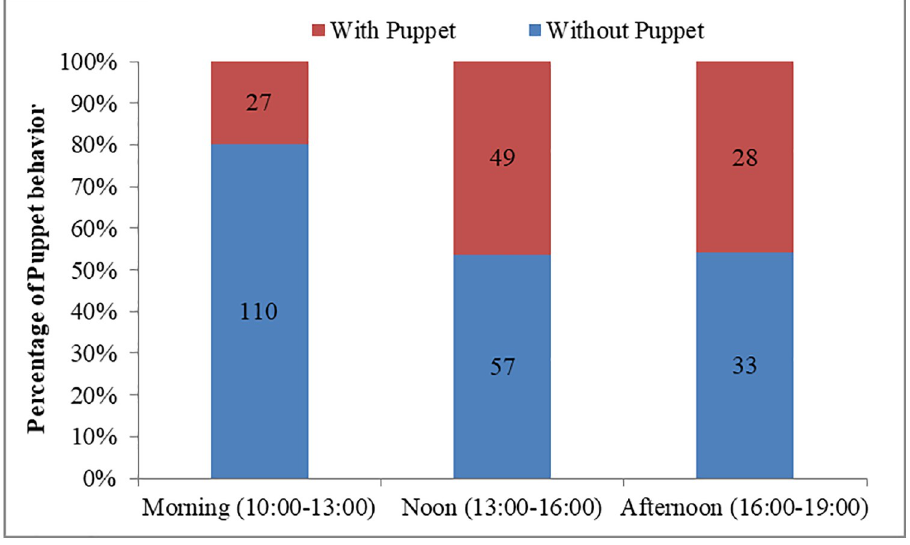
but marginally influenced by weather (Wald = 5.962, df = 2, P = 0.051)., The antelopes bedded more on sunny days than rainy days ( β = 0.911 ± 0.447, Wald = 4.159, df = 1, P = 0.041). The duration of Puppet behavior in females lasted 42.7 ± 41.5 s, compared to adult males (91.5 ± 14.1 s) or sub-adult males (100.3 ± 43.3 s), however, the difference was not significant (F = 0.736, P = 0.482). Similarly, there was no significant effect of weather (F = 0.429, 2, 96 2, 96 P = 0.652), day time (F = 2.462, P = 0.091) and group size (F = 0.035, P = 0.851). 2, 96 1, 96